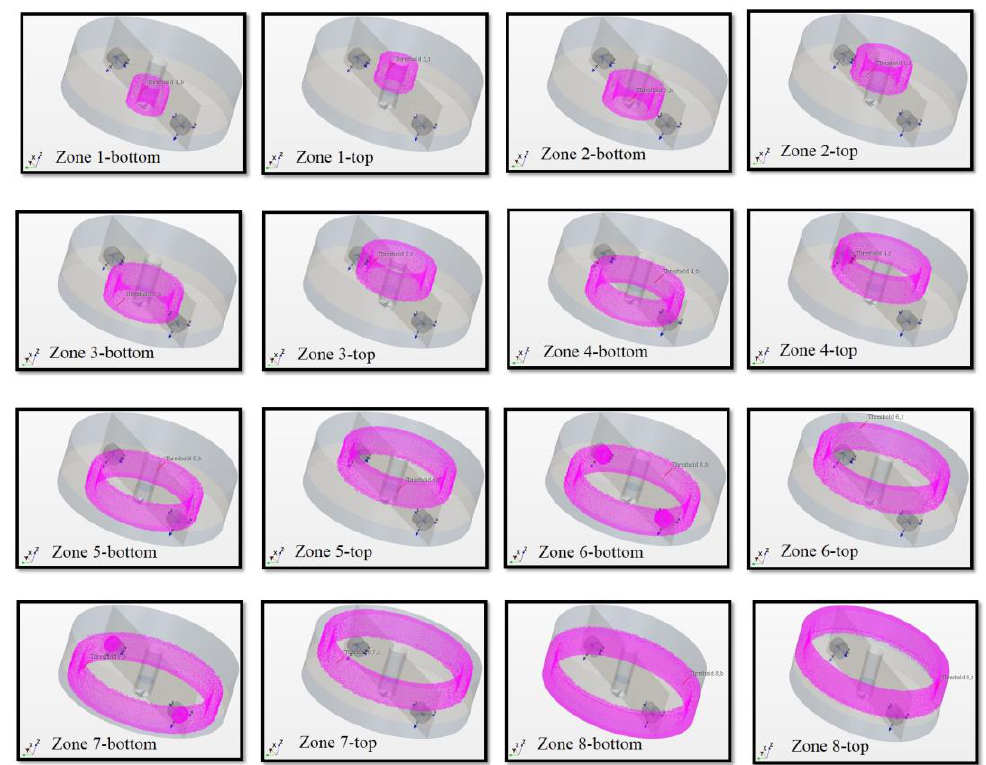
Fig. 8. Shape of partitions for the 8 bottom and 8 top areas in 3D environmental obtained by CFD simulation. In Table 2 the six parameters used as criteria are specified. Each criterion was